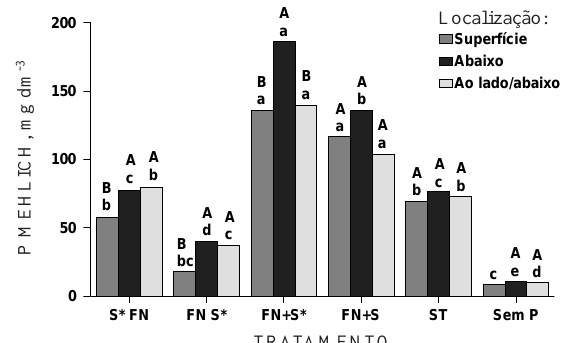
Figura 7. P extraível (Mehlich) nos tratamentos FN revestindo o enxofre inoculado com Acidithiobacillus (FN S*), FN revestido com S inoculado com Acidithiobacillus (S* FN), mistura FN com S inoculado com Acidithiobacillus (FN + S*), mistura FN com S sem Acidithiobacillus (FN + S), superfosfato triplo (ST) e sem adição de fósforo (sem P) de acordo com a localização do adubo. Letras minúsculas comparam as médias dos diferentes tratamentos com adição de P em cada modo de localização do adubo; as maiúsculas, cada tratamento com P nos diferentes modos de localização do